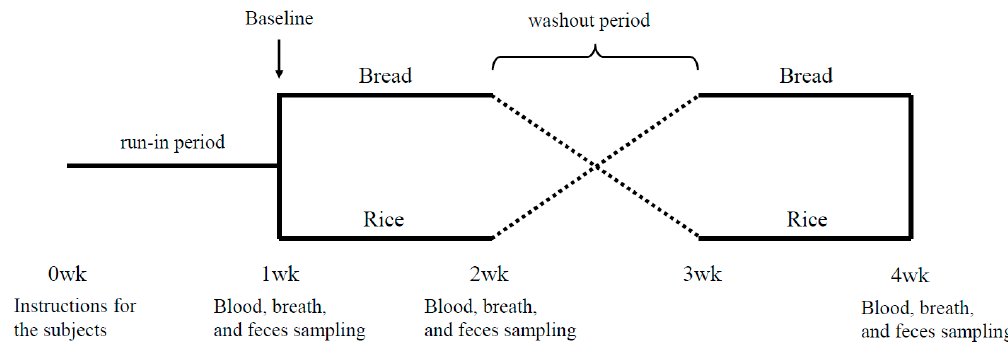
Figure 1. Study design.